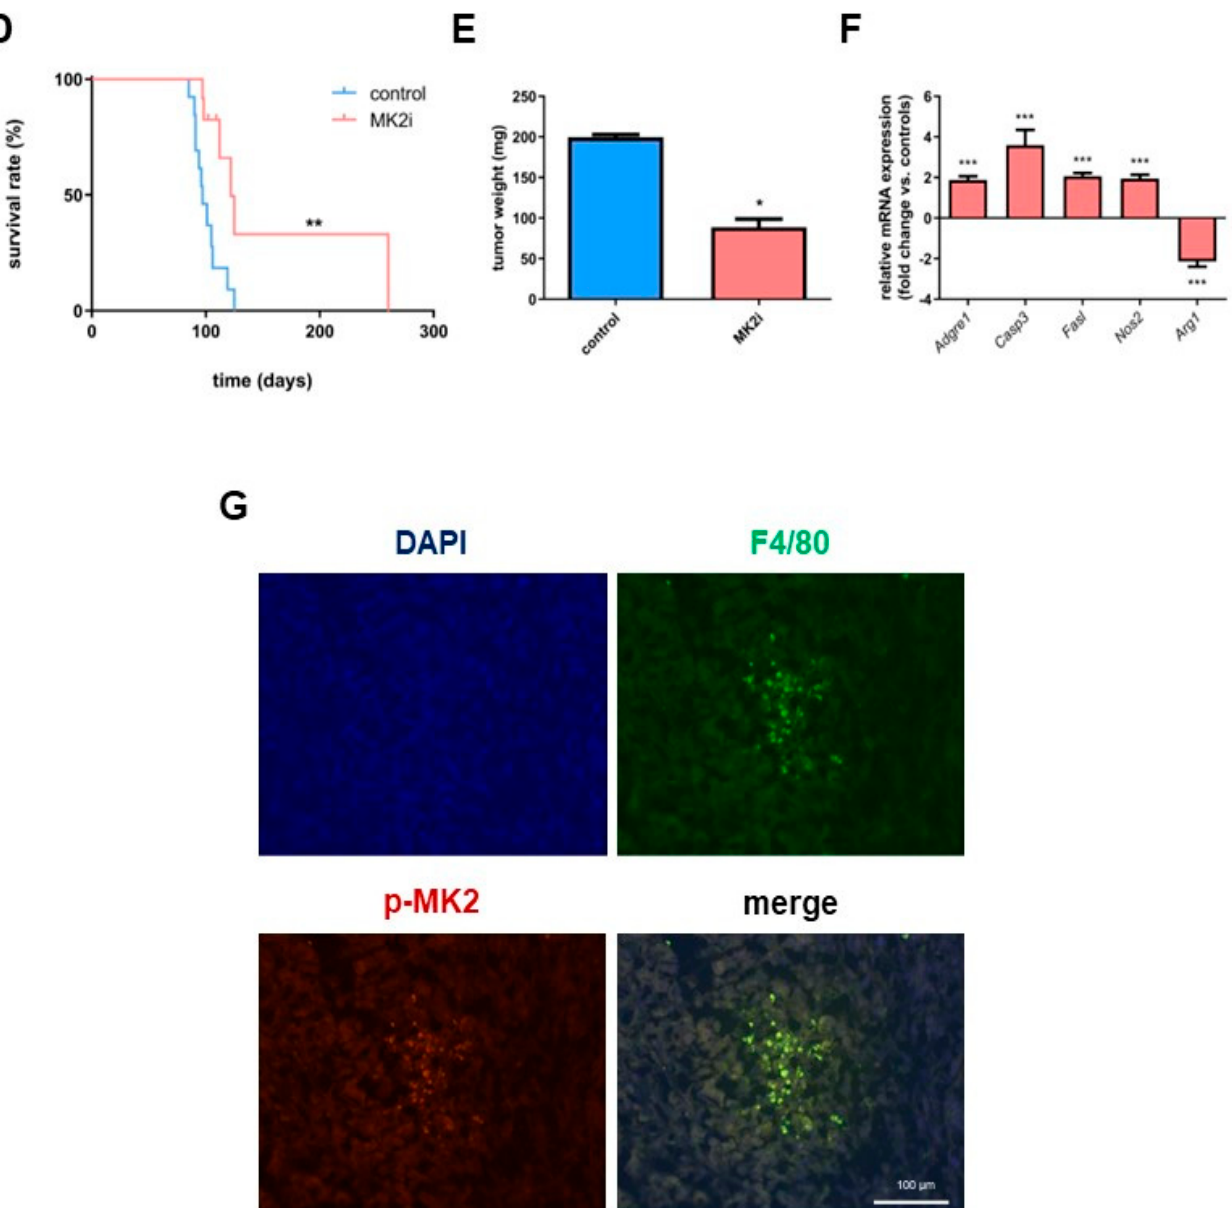
Figure 1. MK2 is activated in mouse PNETs, and its inhibition improves survival time and sup- presses tumor growth in a PNET model . Control pancreas and PNETs were stained for phospho- MK2 ( A ), where was highly expressed as shown by a representative image. The RipTag2 mice were treated as shown in a timeline ( B ) where the sequence of procedures and treatments in the trans- genic RipTag2 mice model of PNETs were presented. Furthermore, immunofluorescence staining ( C ) and Kaplan–Meier curve ( D ) show decreased activity of MK2 and increased survival time in MK2 inhibitor-treated mice (MK2i, red), and the weight of PNETs ( E ) were decreased in mice treated with MK2 inhibitor (n = 14 in each group). In PNETs, the gene expression ( F ) of Adgre1 , Casp3 , Fasl and Nos2 are increased while Arg1 is decreased in mice treated with MK2 inhibitor, (n = 6 in each group). PNETs were stained for phospho-MK2 and F4/80 where co-expression of MK2 and macrophage marker was shown by a representative image ( G ). Data are presented as means ± SEM; * p < 0.05, ** p < 0.01, *** p < 0.001 vs. control.